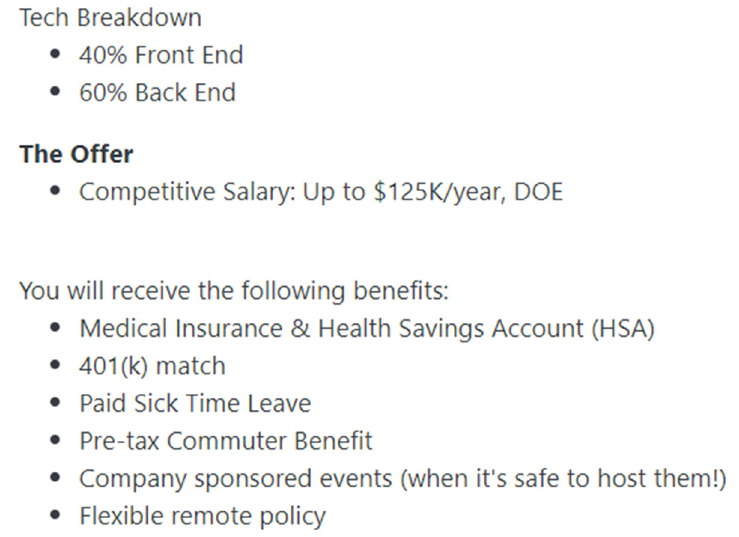
Figure 11. A job advertisement with lists missing job requirements.